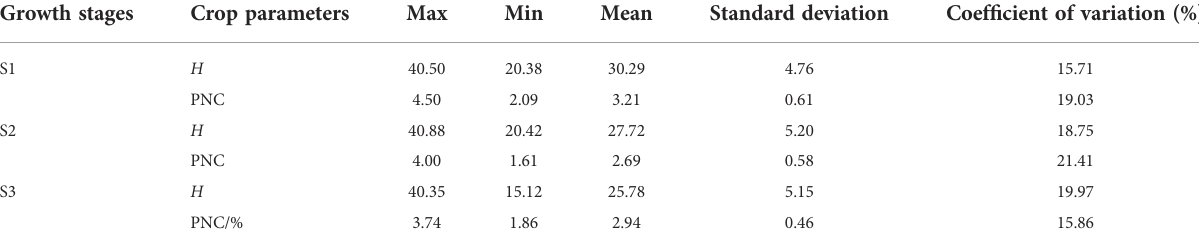
TABLE 1 Statistical analysis of plant height and nitrogen content of potato in different growth stages. Growth